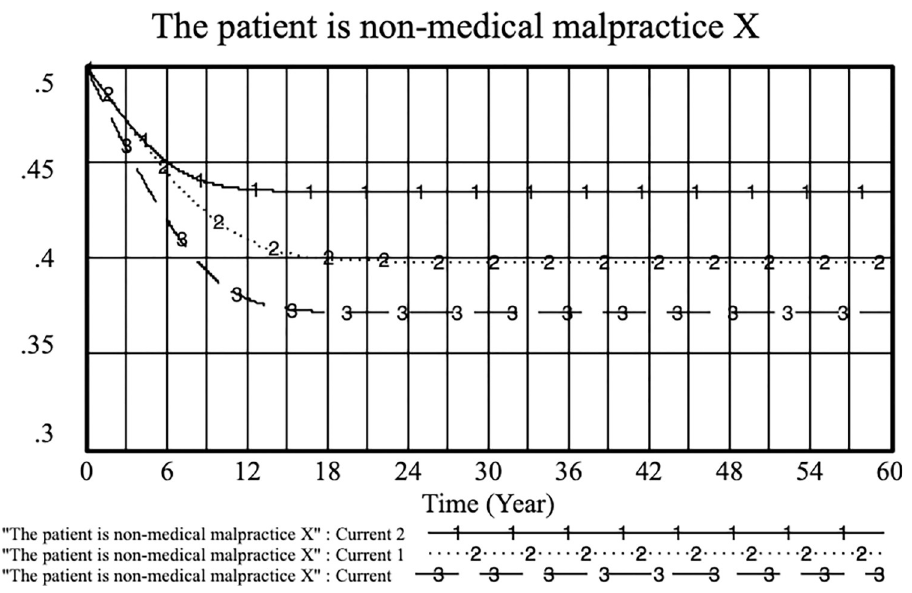
Fig 7. Effects of E and PE 1 on the choice of non-medical malpractice strategy for patients. (current: E = 0.3, PE 1 = 0.5; current 1: E = 0.4, PE 1 = 0.5; current 2: E = 0.4, PE 1 = 0.6).